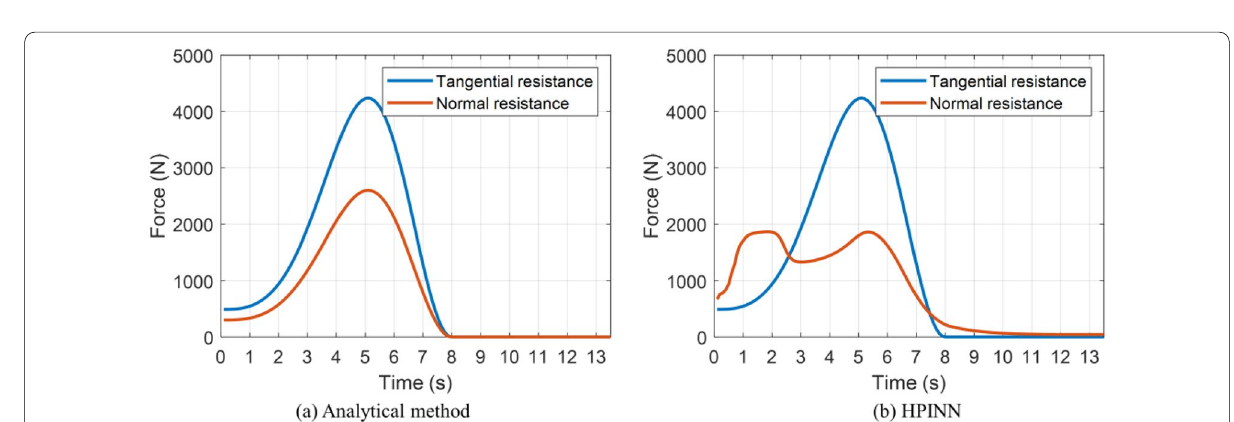
Figure 16 The resistive forces predicted by analytical method and